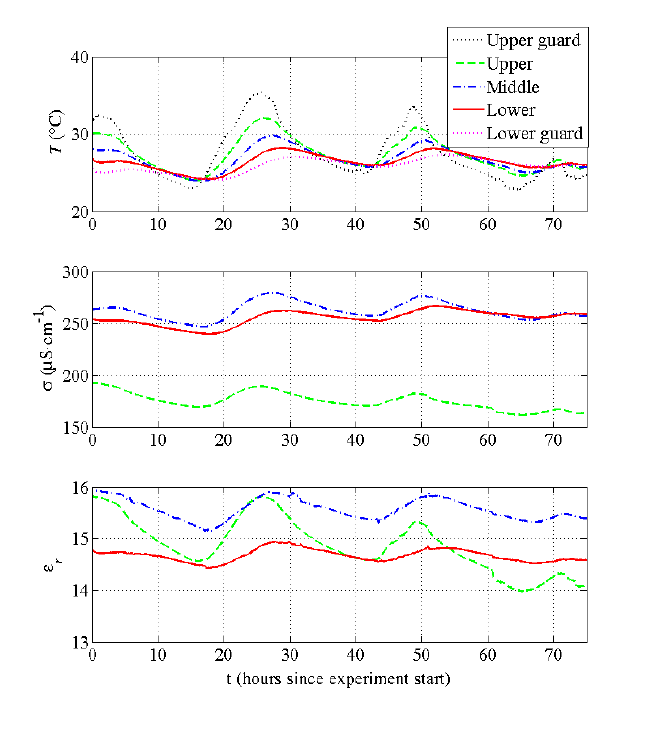
Figure 8. Four-day trial started at 13:54 GMT, 17 July 2014. Data of temperature for all five channels, permittivity and conductivity at 20 MHz for the three middle channels (see Figure 1). They have been recorded with a five-minute resolution. Data accuracy is specified in the